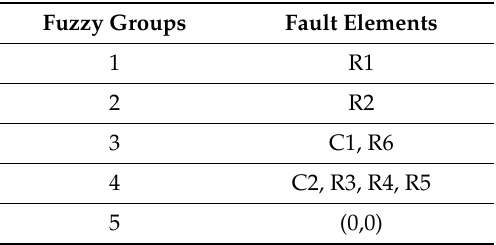
Table 4. Identification of fuzzy groups for simulation test 1.